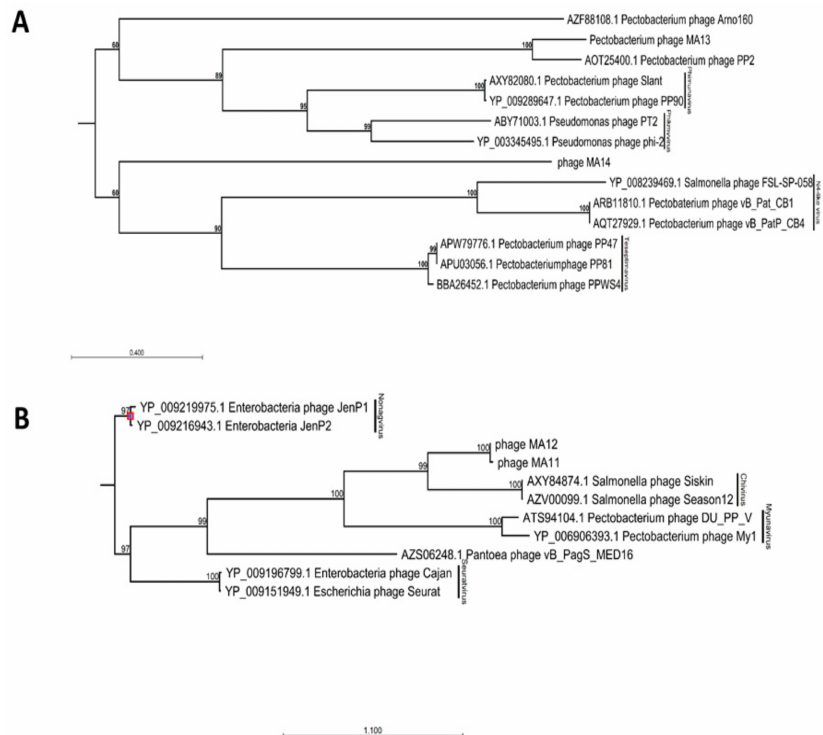
Figure 2. Maximum-likelihood phylogenetic analysis of major capsid proteins of phages isolated in this study constructed using a neighbor–joining method with protein substitution model Dayho ff (PAM) using CLC Genomic Workbench 9.5.4. ( A ) Members of Podoviridae family phages. ( B ) Members of Siphoviridae family phages. For phages obtained from GenBank capsid proteins accession numbers followed by phages names; phages isolated in this study: phage MA11, phage MA12, phage MA13 and phage MA14. Bootstrap probabilities values < 50% were collapsed.